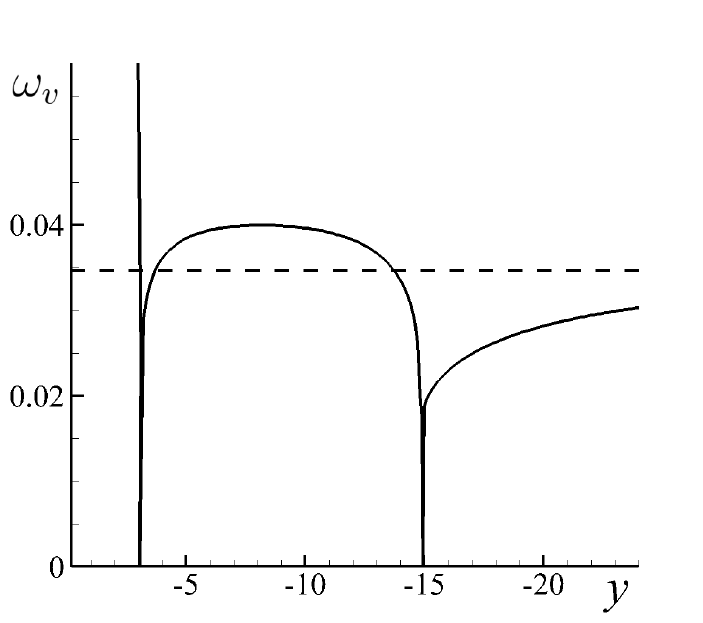
Figure 18. Rotating frequency of the phase portrait similar to the one shown in Figure 3a. The dashed straight line corresponds to the asymptotic rotation frequency imposed by the exterior deformation flow (cid:113) Ω 2 − S 2 2 . Zero values of the frequency correspond to the separatrices of the vortex phase portrait. 0 0 The plateau in-between the zero values serves as the perturbation frequency for the advection